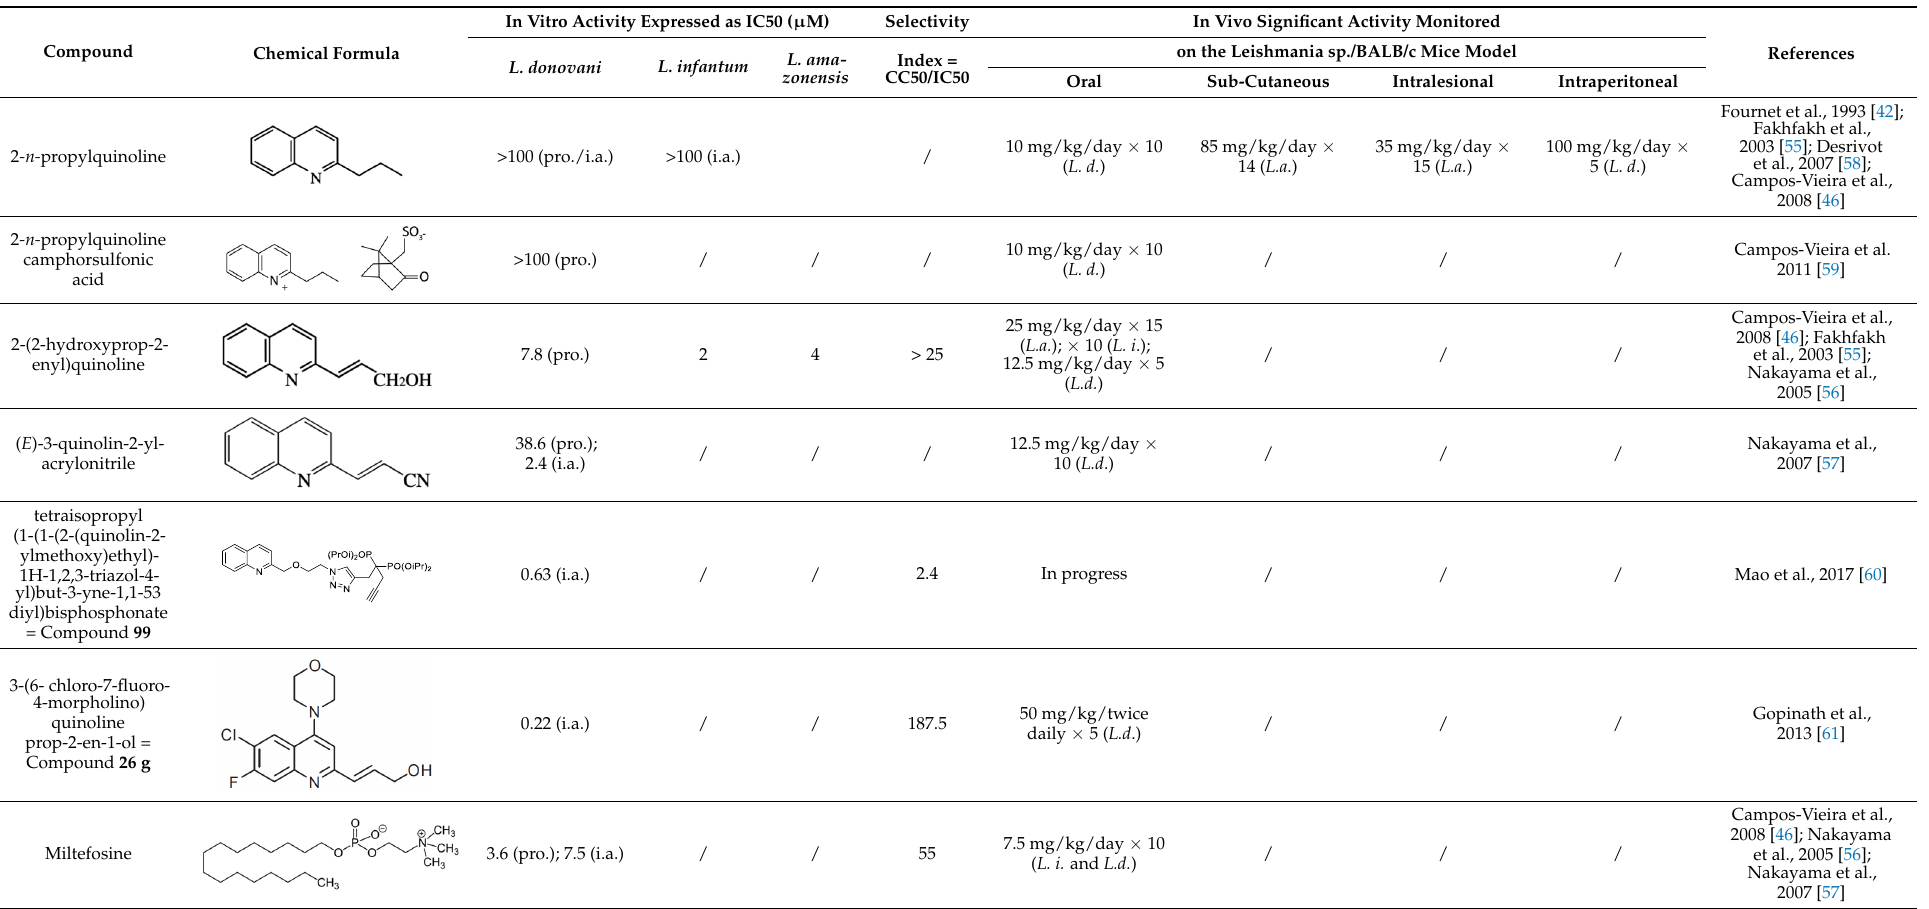
Table 1. In vitro and in vivo antileishmanial activity of some of the most promising 2-substituted quinolines.